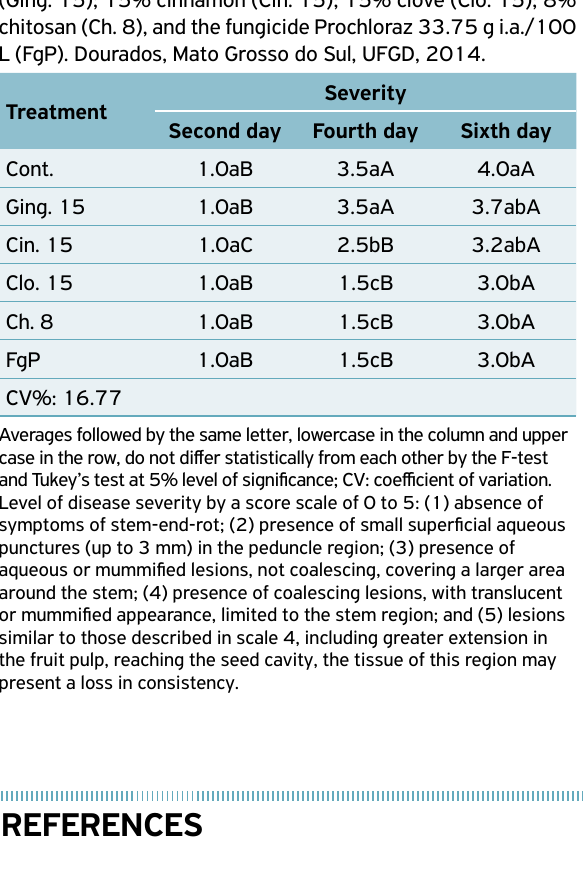
Table 3. Severity of anthracnose in “Formosa” papaya “Tainung 1”, under different treatments: control (Cont.); 15% ginger (Ging. 15); 15% cinnamon (Cin. 15); 15% clove (Clo. 15);